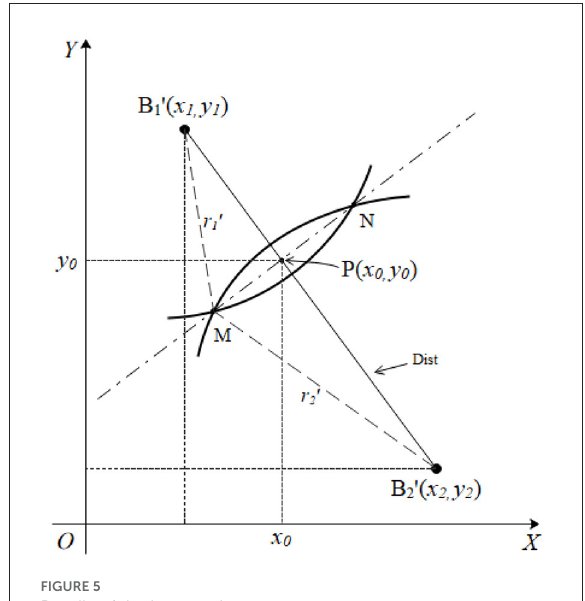
FIGURE5 Details of the intersection.